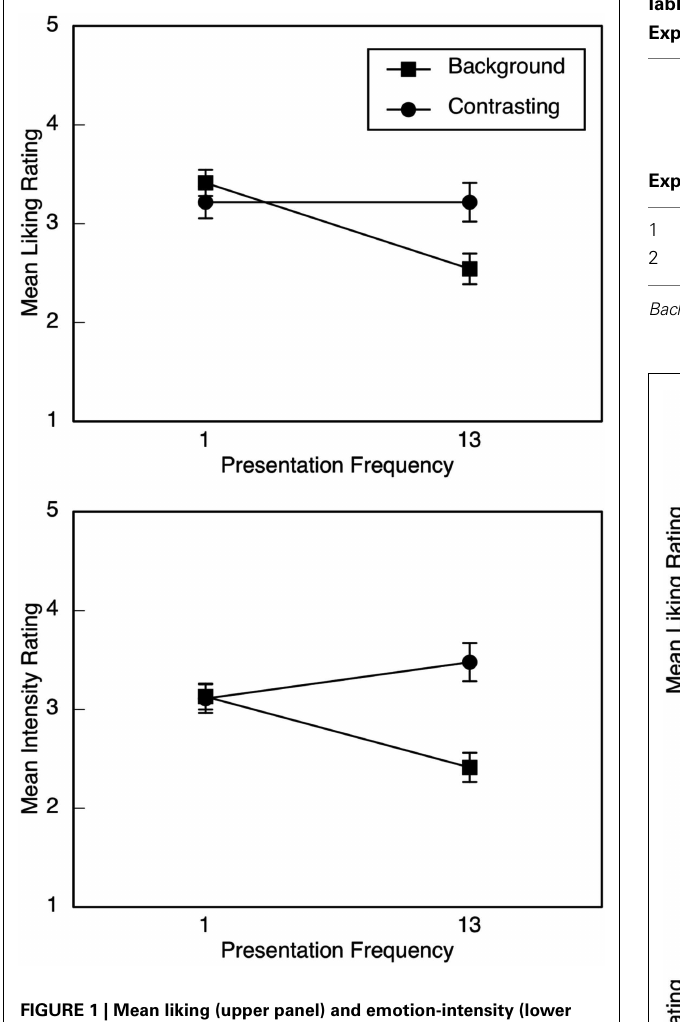
FIGURE 1 | Mean liking (upper panel) and emotion-intensity (lower panel) ratings in Experiment 1, illustrated as a function of emotion type (background or contrasting) and presentation frequency of the background emotion (1 or 13). Error bars are SE.